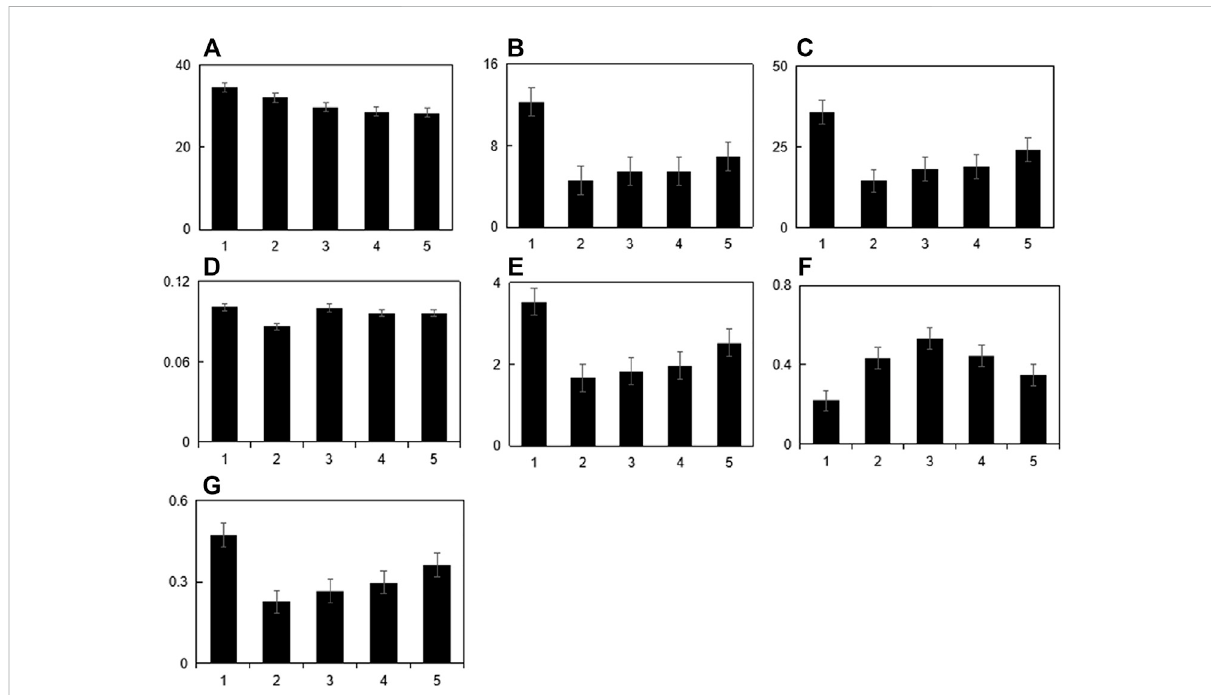
FIGURE 6 Bonemineraldensityindexandbonetrabecularindex.Note: (A) TVMM3(selectedvolumeofROI), (B) :BVMM3(bonevolume), (C) :BV/TV%(bone volume fraction), (D) :Tb.Th mm (bone trabecular thickness), (E) :Tb.N 1/mm(bonetrabecular number), (F) :Tb (Bonetrabecular separation), (G) BMD G/ cm3 (bone density),1. Normal rats group,2. Rat model + placebo group, 3. Rat model + low dose,4. Rat model + medium dose5. Rat model + high dose* *represents p < 0.05.